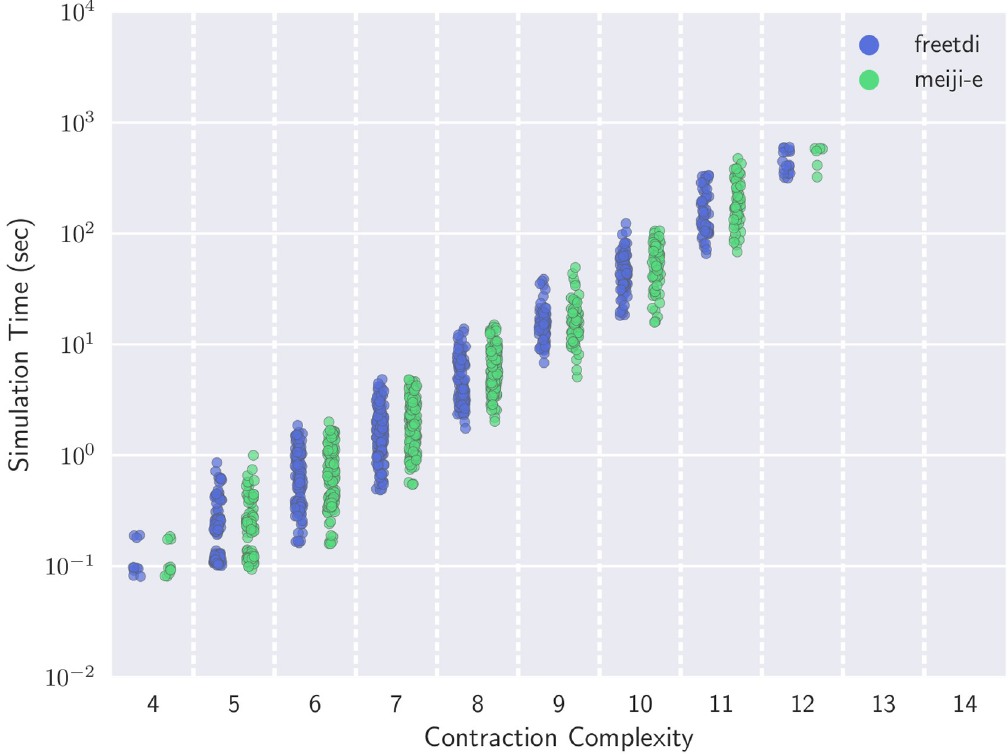
Fig 7. Simulation time is tightly correlated with the contraction complexity of a network. While exact algorithms freetdi and meiji-e may generate different tree decompositions and thus contraction sequences with the same treewidth, the differences have little impact on simulation